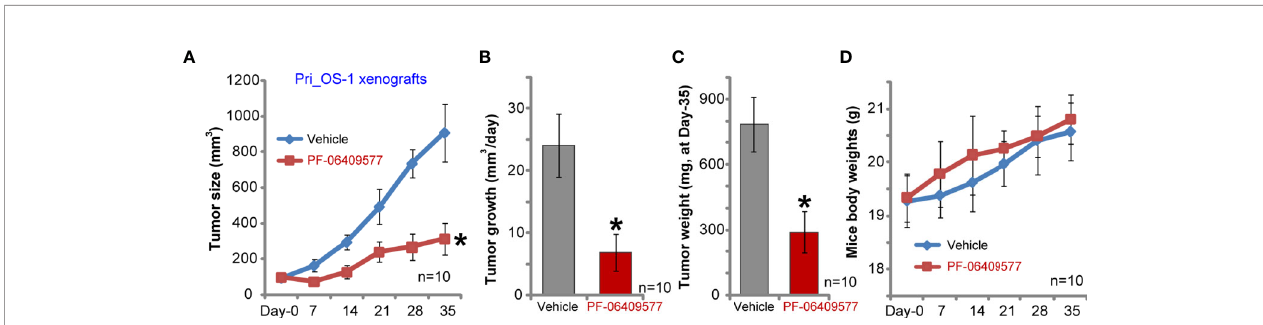
FIGURE 6 | PF-06409577 administration inhibits primary human OS cell growth in SCID mice. SCID mice bearing Pri_OS-1 xenograft tumors were administrated with vehicle control ( “ Vehicle ” , saline) or PF-06409577 (10 mg/kg, oral gavage, daily for 24 days). Tumor volumes (A) and mice body weights (D) were measured at every 7 days for a total of 35 days. The estimated daily tumor growth, in mm 3 per day, was calculated (B) . At the end of animal experiments, all tumors were weighted individually (C) . Data were presented as mean ± standard deviation (SD). * p < 0.05 vs. “ Vehicle ” (A – C)